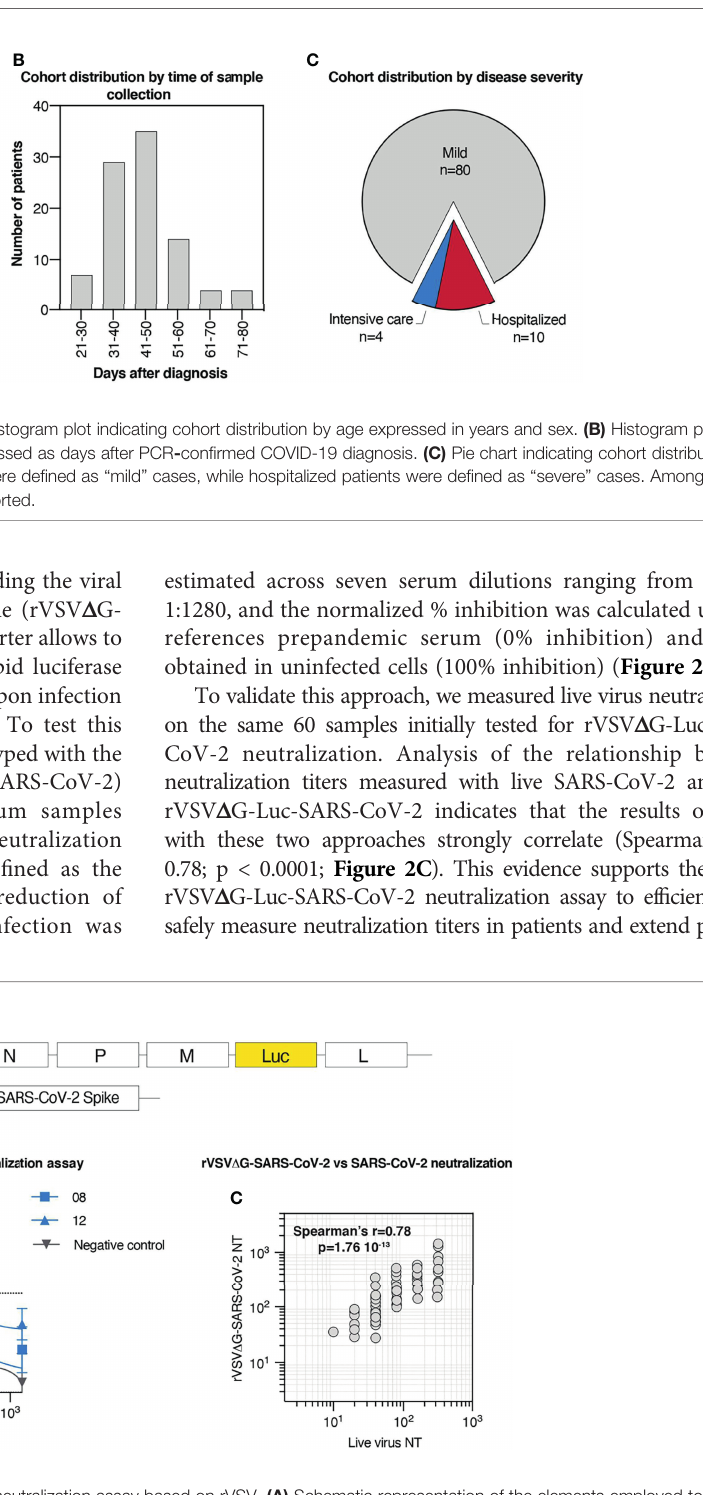
FIGURE 2 | Development and validation of a high throughput neutralization assay based on rVSV. (A) Schematic representation of the elements employed to generate rVSV D G-SARS-CoV-2 pseudotypes. rVSV D G-Luc encodes for N, P, M, and L VSV proteins, but lacks G coding sequence, which has been replaced by the coding sequence of Luciferase. SARS-CoV-2 Spike construct encodes for SARS-CoV-2 glycoprotein. (B) rVSV D G-SARS-CoV-2 neutralization assay displaying % of viral inhibition across 7 sample dilutions. Representative data (mean ± SD) of two samples from COVID-19 convalescent individuals (# 08; 12) and a prepandemic serum sample (negative control) are shown. (C) Correlation between serum neutralization titers obtained with rVSV D G-SARS-CoV-2 pseudotypes and live SARS- CoV-2 across 60 randomly selected patients from our cohort.